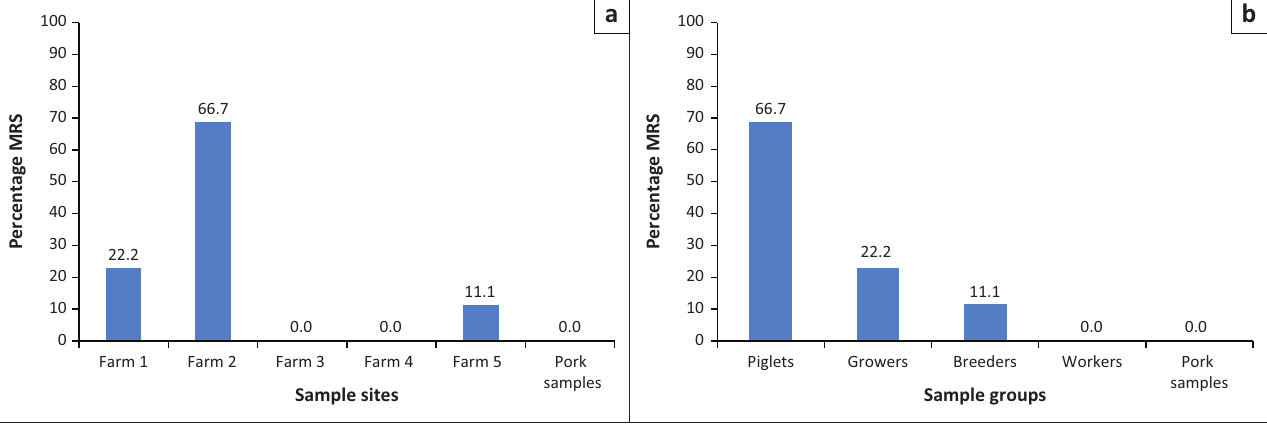
FIGURE 1: Occurrence of methicillin-resistant staphylococci (MRS) along the pig-production chain in Ibadan. (a) Distribution of methicillin-resistant staphylococci in different sample sites. (b) Distribution of methicillin-resistant staphylococci in different sample